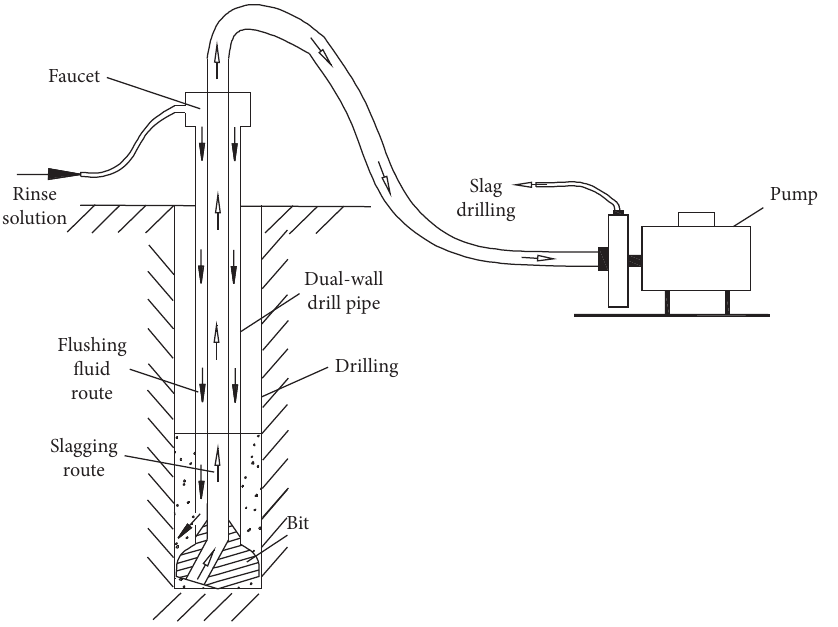
Figure 2: Slagging diagrammatic sketch of pump suction reverse